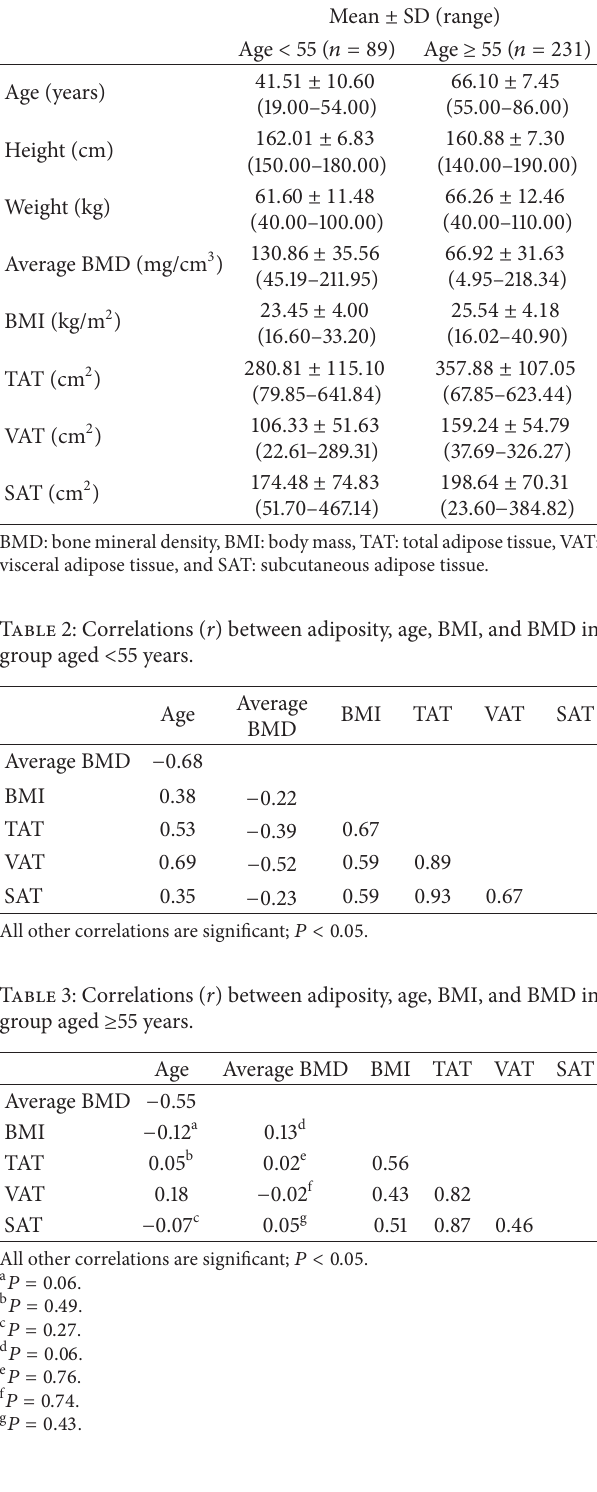
Table 1: Descriptive characteristics of the subjects.